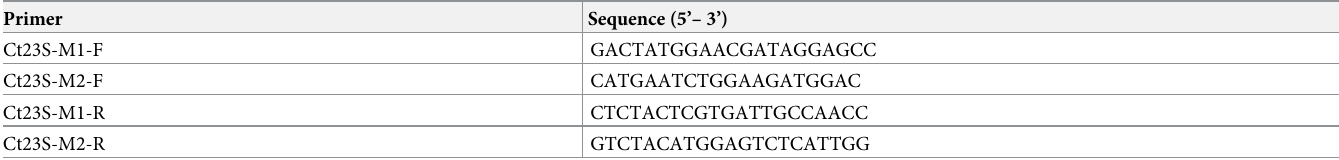
Table 1. Designed primers for the Chlamydia trachomatis 23S rRNA gene.